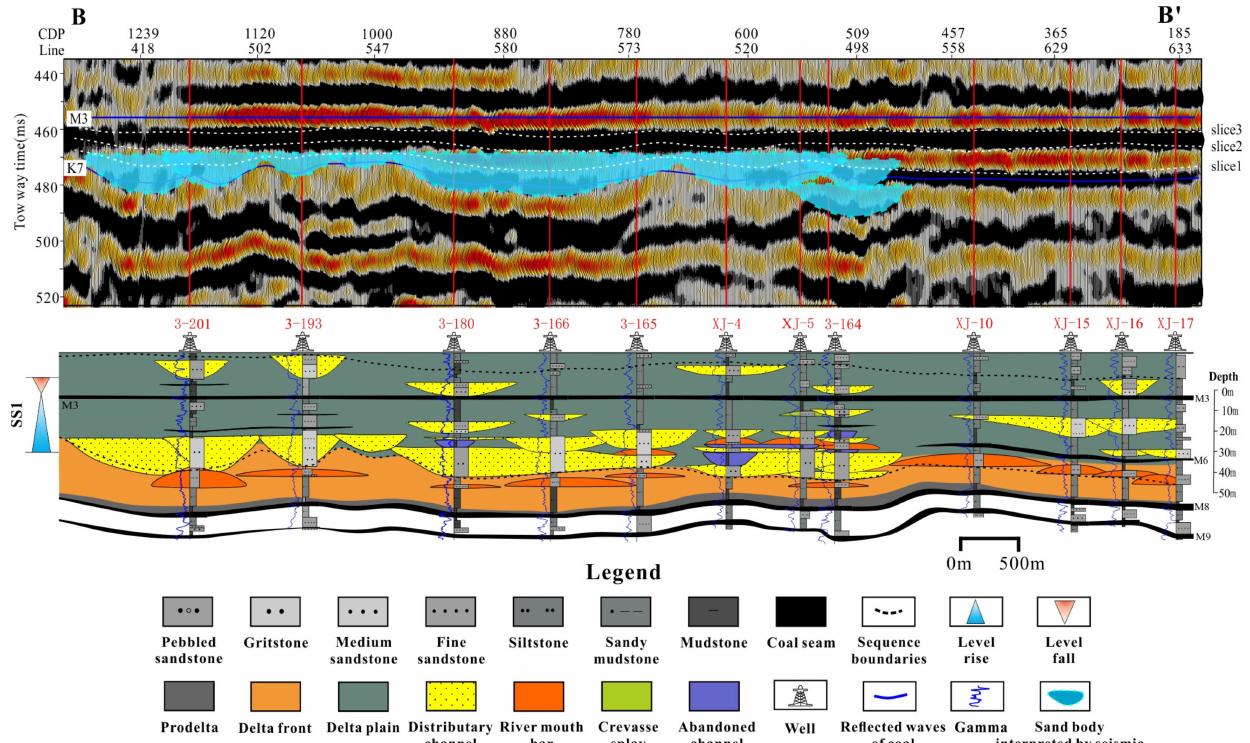
Figure 13. Seismic–geological comprehensive interpretation of sand bodies distribution and sedimen- tary facies (( B – B (cid:48) )